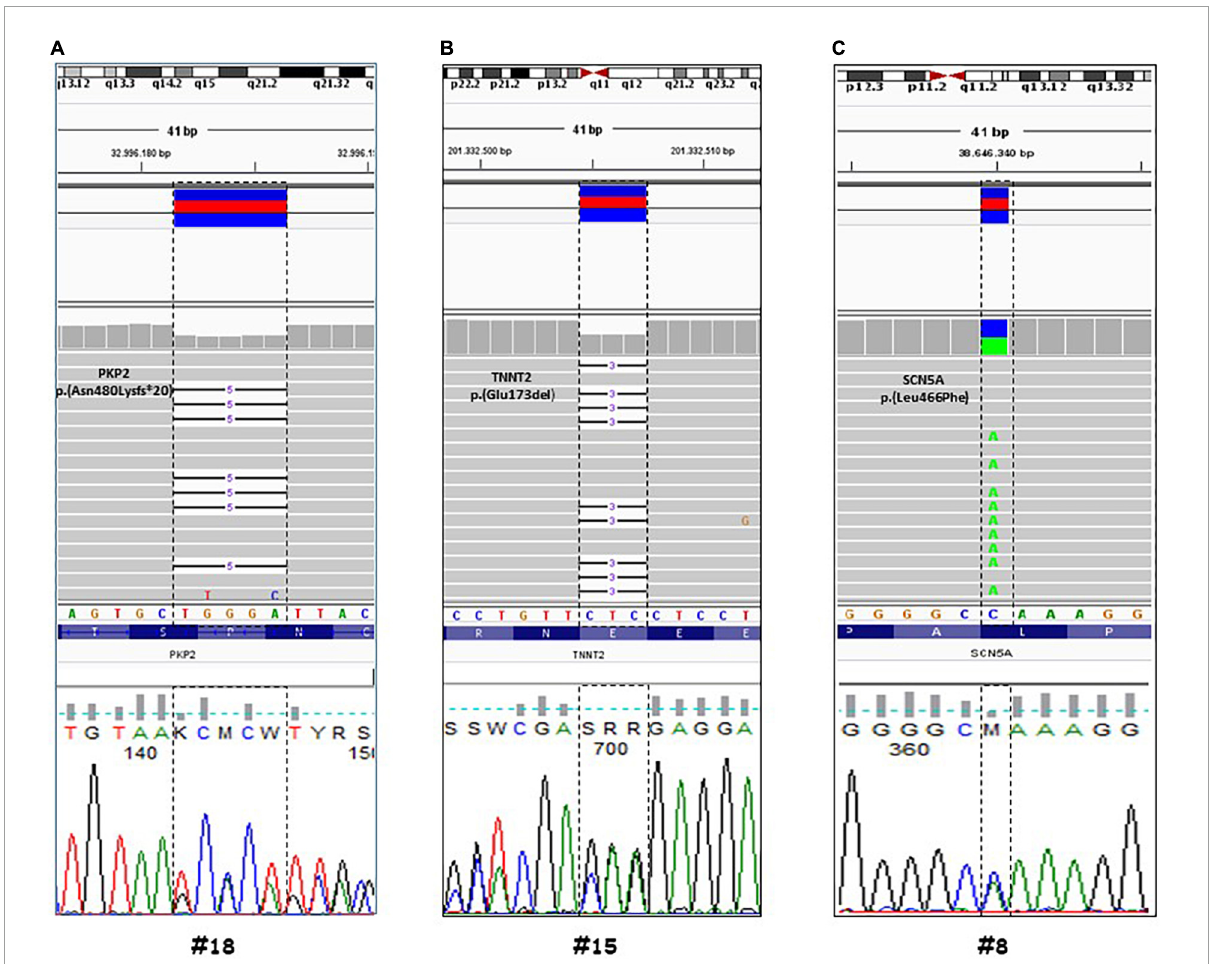
FIGURE3 Genetic analysis by next generation sequencing (NGS) of three selected cases. Visualization by integrative genomic viewer (IGV) software of NGS data (through alignment of enriched sequences to Hg19). Case #18, (A) a heterozygous deletion in the PKP2 gene (Genbank accession no. NM_004572.3), c.1440_1444del p.(Asn480Lysfs*20). Case #15, (B) a deletion in TNNT2 (Genbank accession no. NM_000364.2), c.517_519del p.(Glu173del) in heterozygous state. Case #8, (C) a missense variant in the SCN5A gene (Genbank accession no. NM_198056), c.1398G > T p.(Leu466Phe). The detected variants were confirmed by Sanger